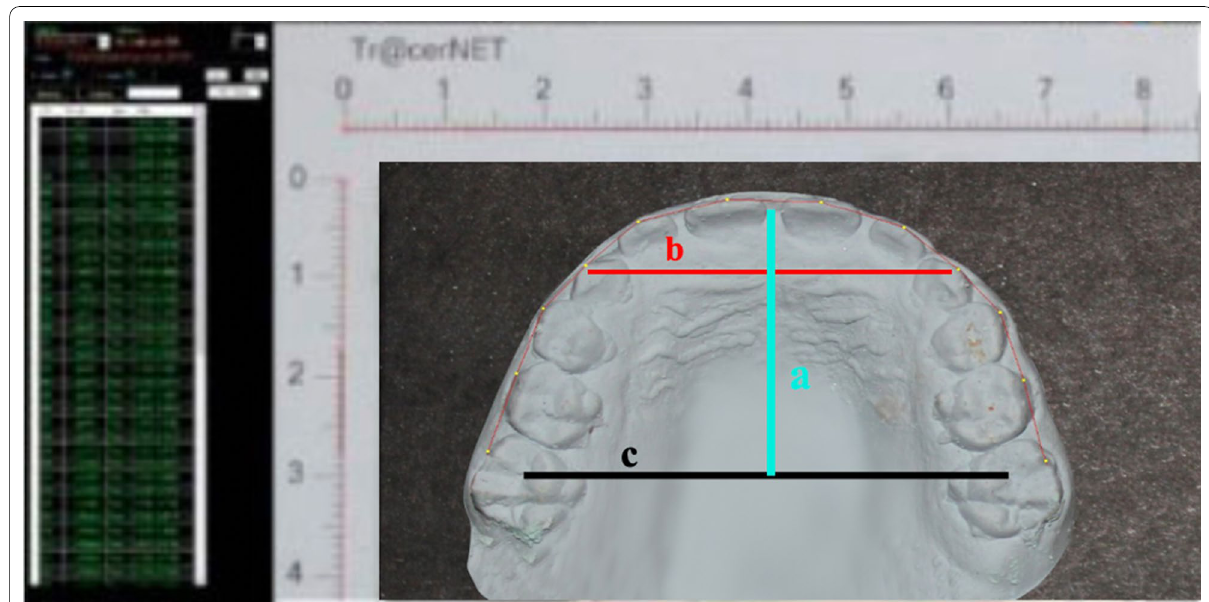
Fig. 1 Measurement of arch dimensions using TracerNet, a showing total arch length, b intercanine width, c inter‑first‑molar